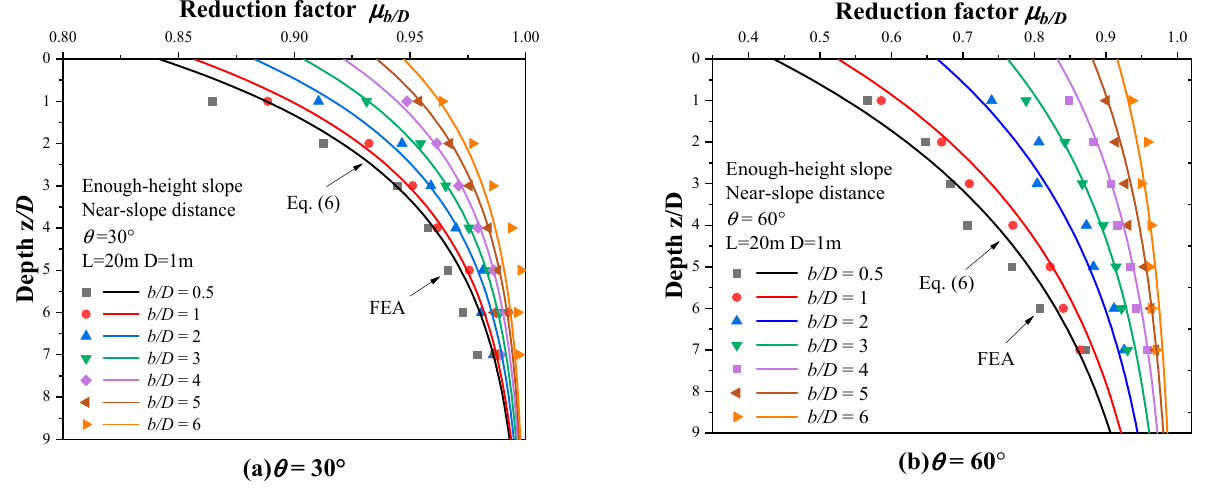
Figure 7. Effect of b / D on µ for ( a ) θ = 30 ◦ ; ( b ) θ = 60 ◦ .